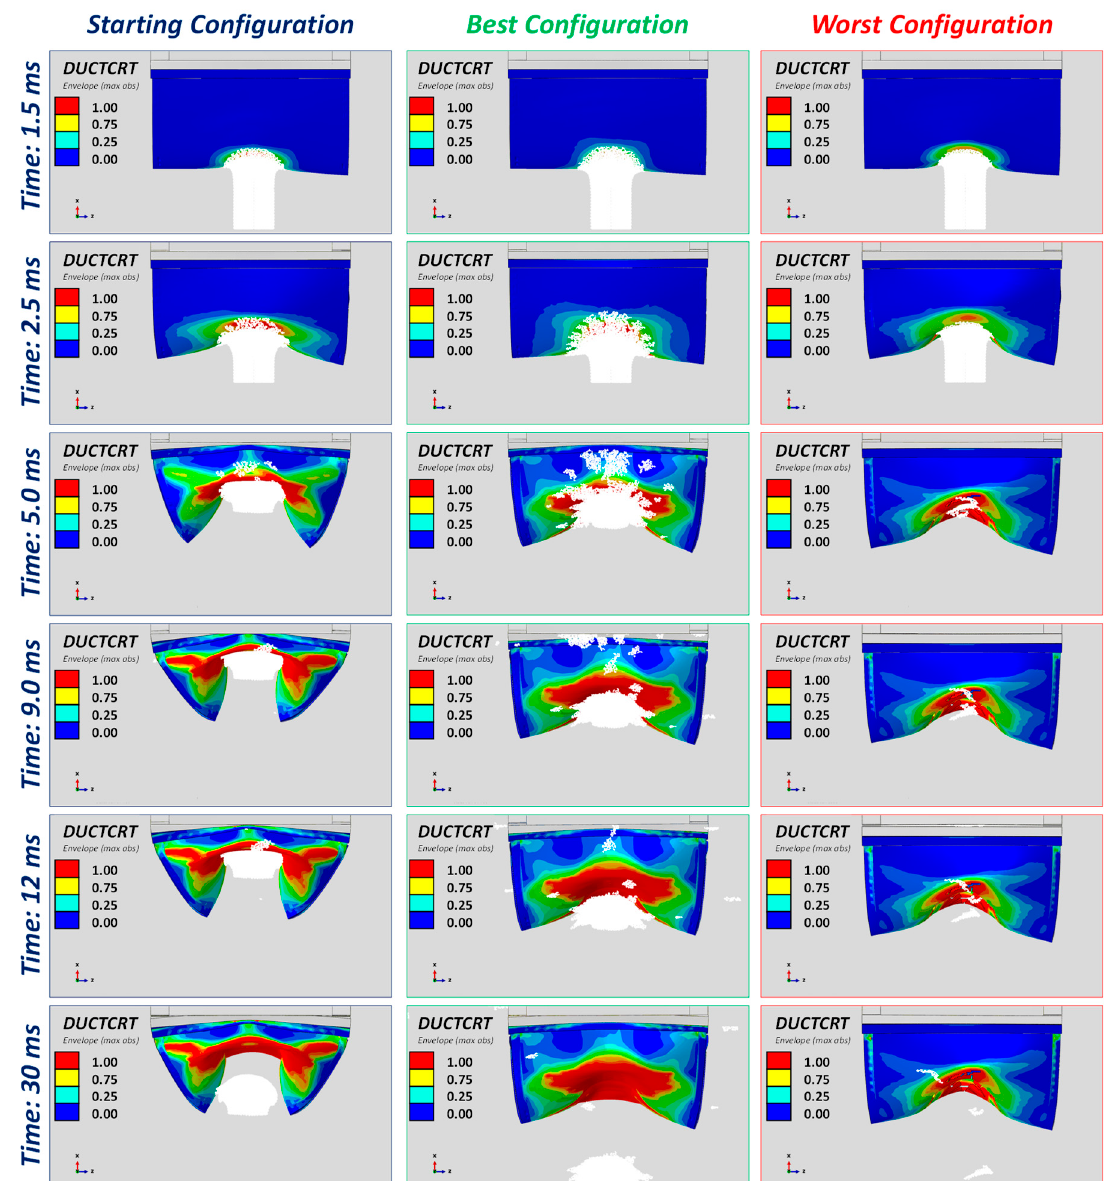
Figure 10. Ductile criteria envelope for starting, best and worst configuration at different time steps.